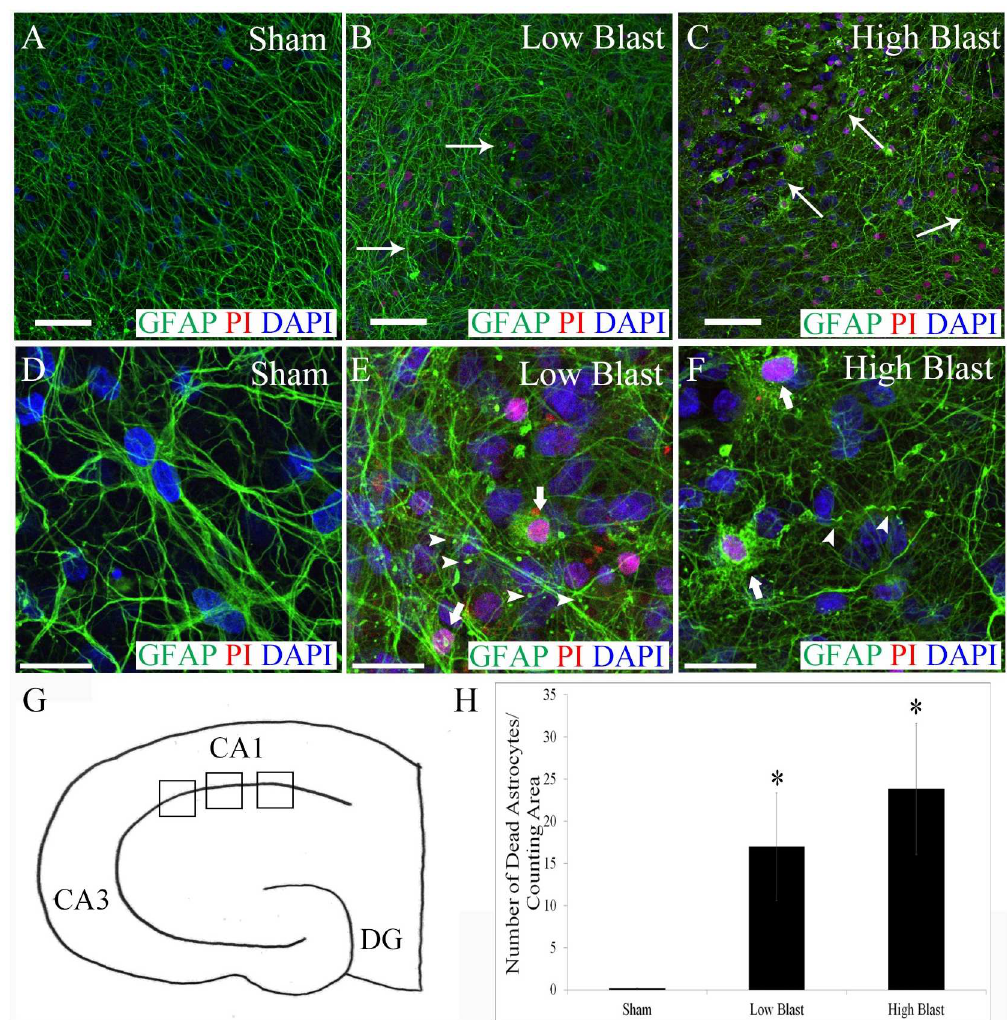
Fig 1. Acute morphological changes and demise of astrocytes following blast exposure. Representative confocalimages acquiredin the CA1 hippocampal regionfrom sham controls (A, D), low-blast(B, E), and high-blast (C, F) OHCs that were fixed at 2 h followinginjury and stainedwith an anti-GFAP antibody (green), PI (red), and DAPI (blue). Shearingof the astrocytes (thin arrows) was detected in OHCs exposedto blast overpressure (B, C) while it was absent in the sham controls (A). Clasmatodendrosis(arrowheads) was also observedin the low- (E) and high- blast (F) groups, but it was very infrequentin the sham control group (D). At the same time point, only a few dead astrocytes were present in sham control OHCs (D) whilesignificantnumber of deadastrocytes (thick arrows) was revealedin the low- (E) and high-blast (F) groups. (G) Schematic diagram of OHC, indicatingapproximate locationsin the CA1 region(boxes) where images for quantificationof dead astrocytes were taken. (H) Number of dead astrocytes per counting area in the CA1 hippocampal regionat 2 h followinginjury was significantly higherin both the low- ( * ; P < 0.05; n = 5) and high-blastgroups( * ; P < 0.05; n = 5) comparedto the sham control group (n = 5). Scale bars (A-C) 50 μ m (D-F) 20 μ